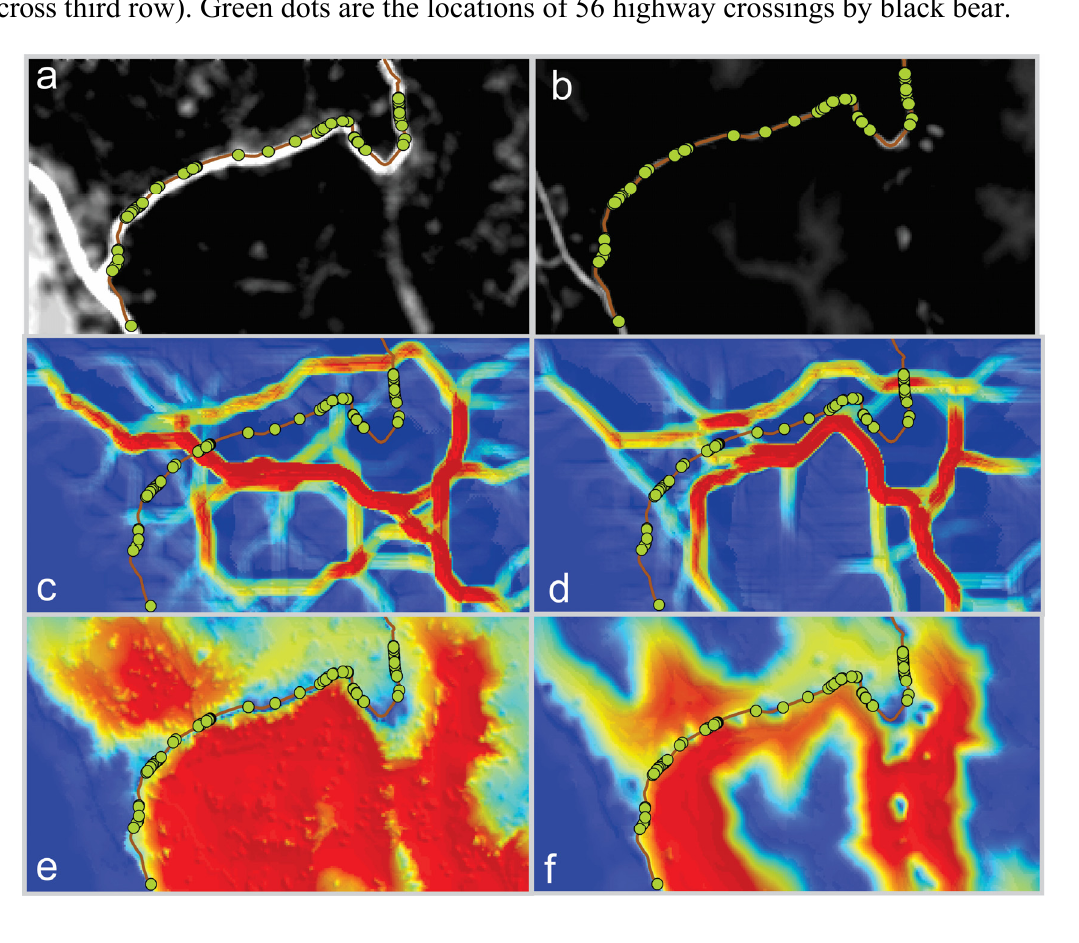
resistance map used (genetic based, down the first column; or movement based, down the second column) and the type of connectivity model (average neighborhood resistance, across first row; factorial least cost paths, across second row; cumulative resistant kernels, across third row). Green dots are the locations of 56 highway crossings by black